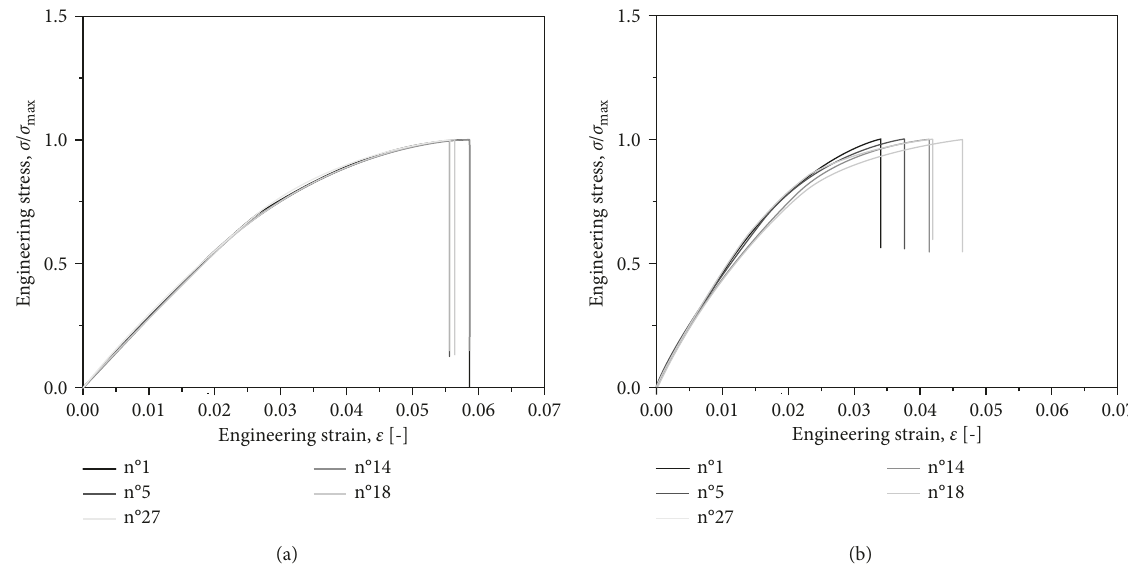
Figure 7: Normalized stress strain for (a) flexion samples and (b) tensile